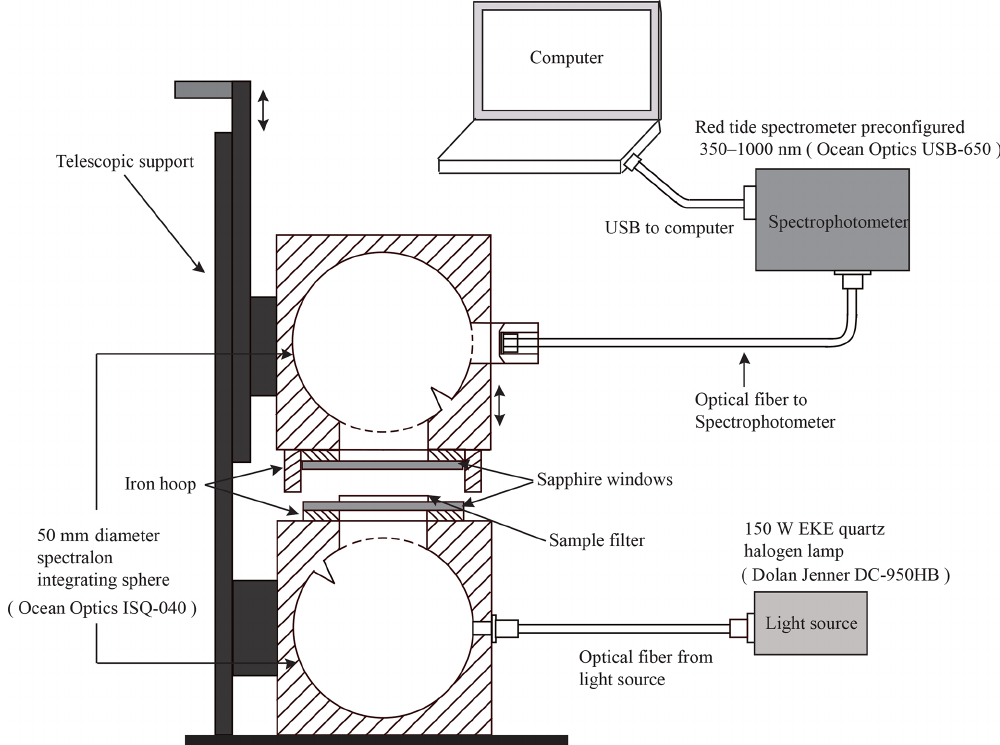
Figure 2. Schematic diagram of the improved two-sphere integrating